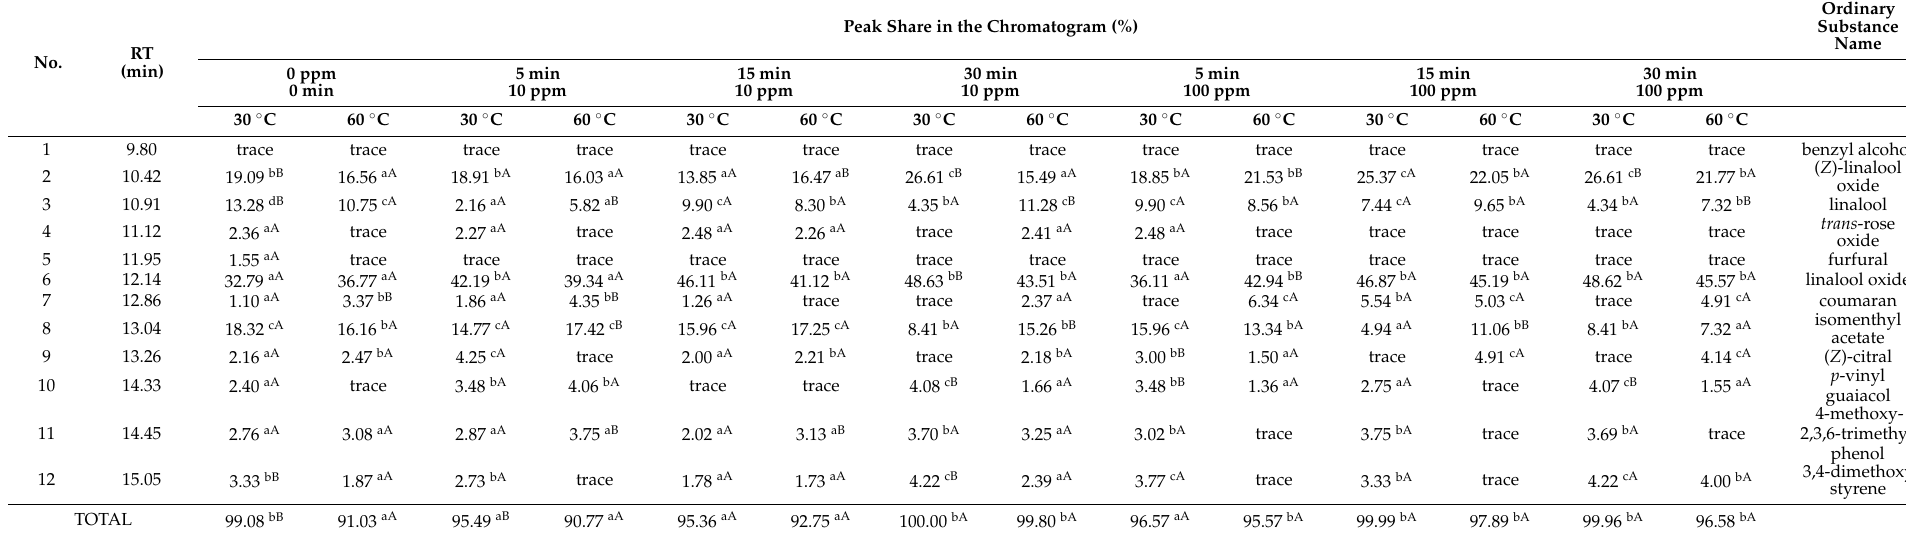
Table 4. Volatile compounds’ composition of syrups produced from black